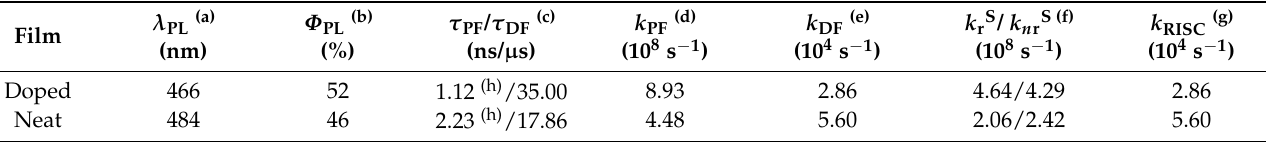
Table 1. Photophysical parameters of PDPC in 20% doped and neat